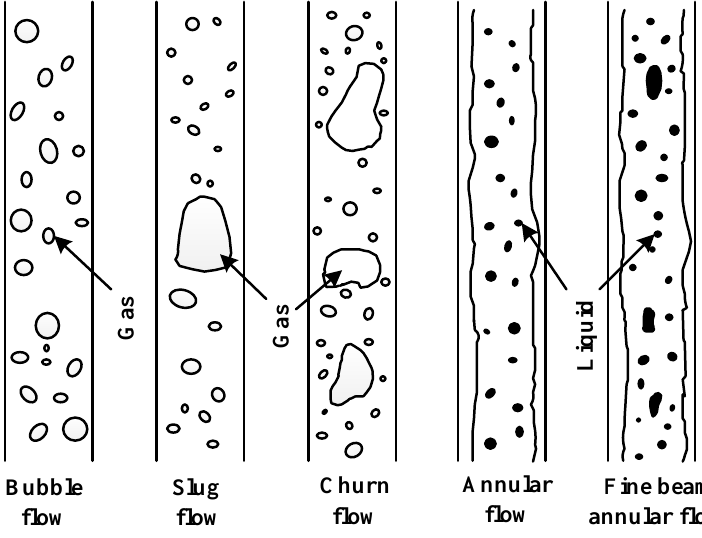
Figure 3. Two-phase flow patterns in vertical CBM wells